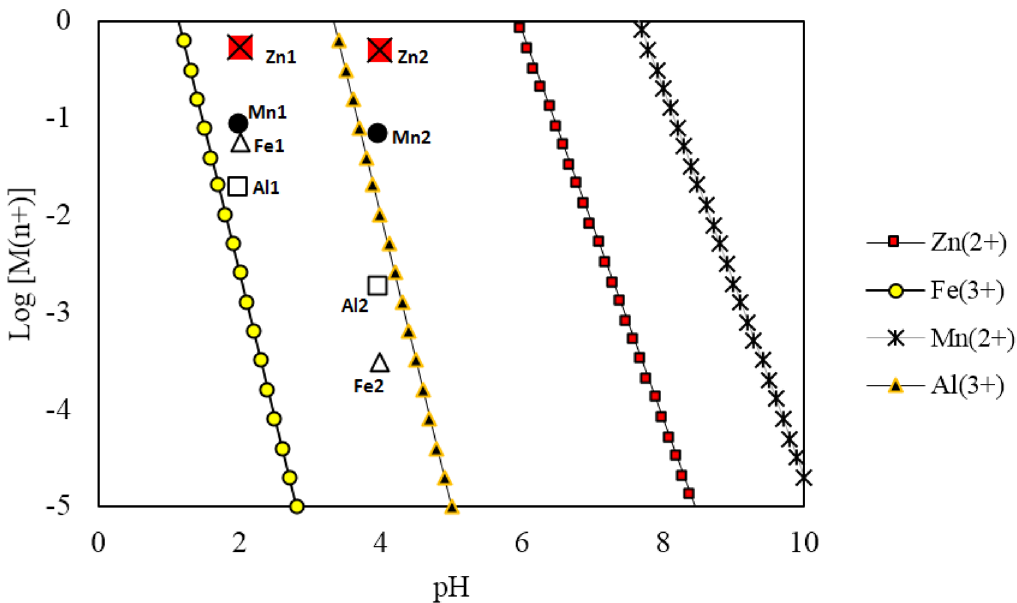
Figure 5. Hydroxide precipitation diagram for Fe 3+ , Al 3+ , Zn 2+ and Mn 2+ cations (Monhemius 38 was used for determination of the products’ solubility). M1 means metal concentration at pH = 2 and M2 means metal concentration at pH = 4 (M = Zn, Fe, Mn, and